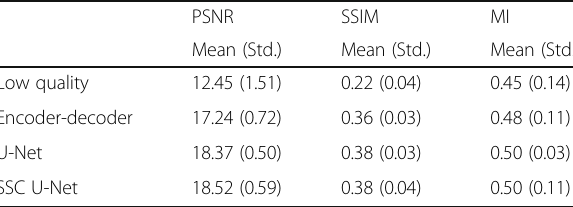
Table 2 Results of the three models on phantom dataset Table 3 Results of the three models on in vivo